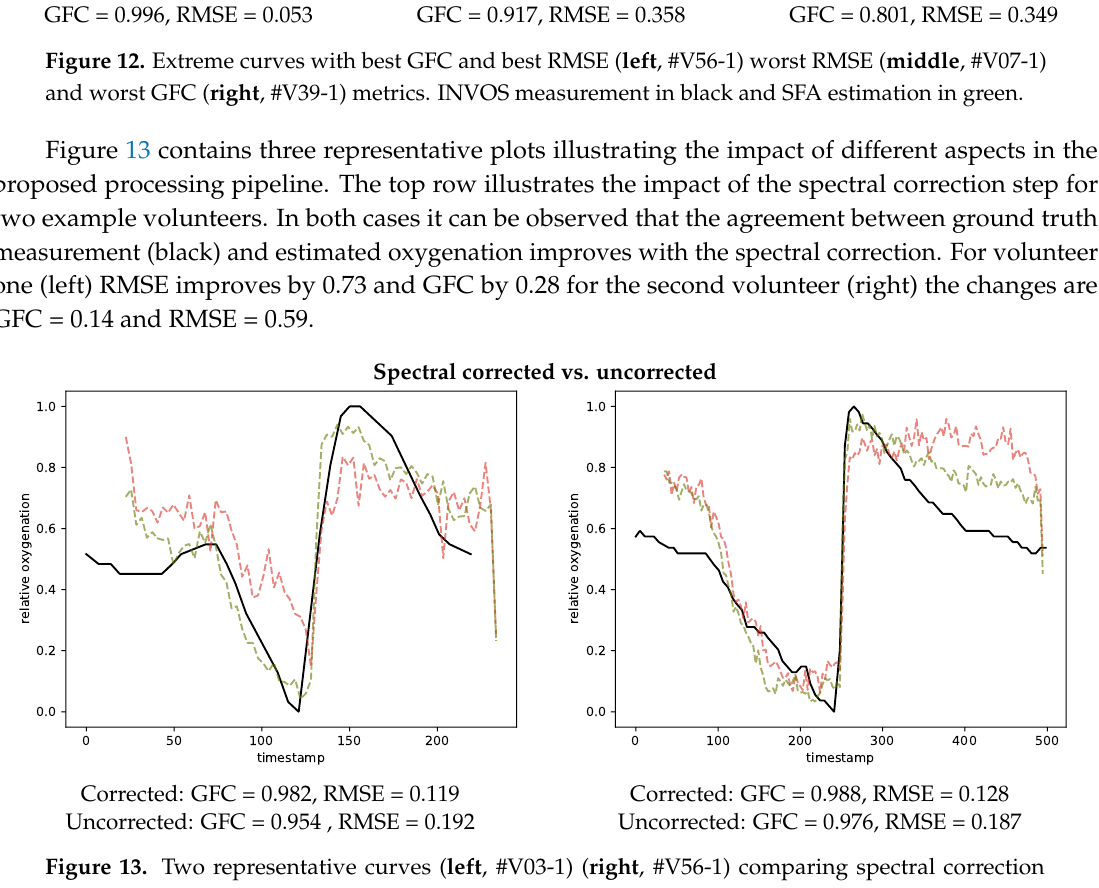
Figure 13. Two representative curves ( left , #V03-1) ( right , #V56-1) comparing spectral correction (green) and spectral uncorrected (red) oxygenation estimations in comparison to the INVOS measurement